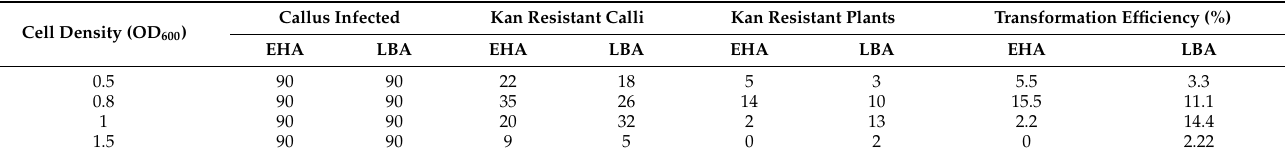
Table A1. Effect of cell density on transformation efficiency of callus derived from seeds of P. scrobiculatum L. Cell Density (OD 600 )